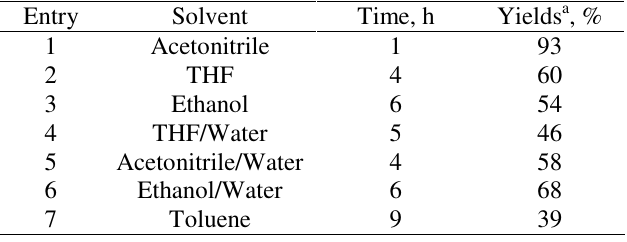
Table 1. Optimization of reaction condition for synthesis of 2, 4, 5-triphenyl 1 H -imidazole derivatives using 5 mol% ZnO catalyst